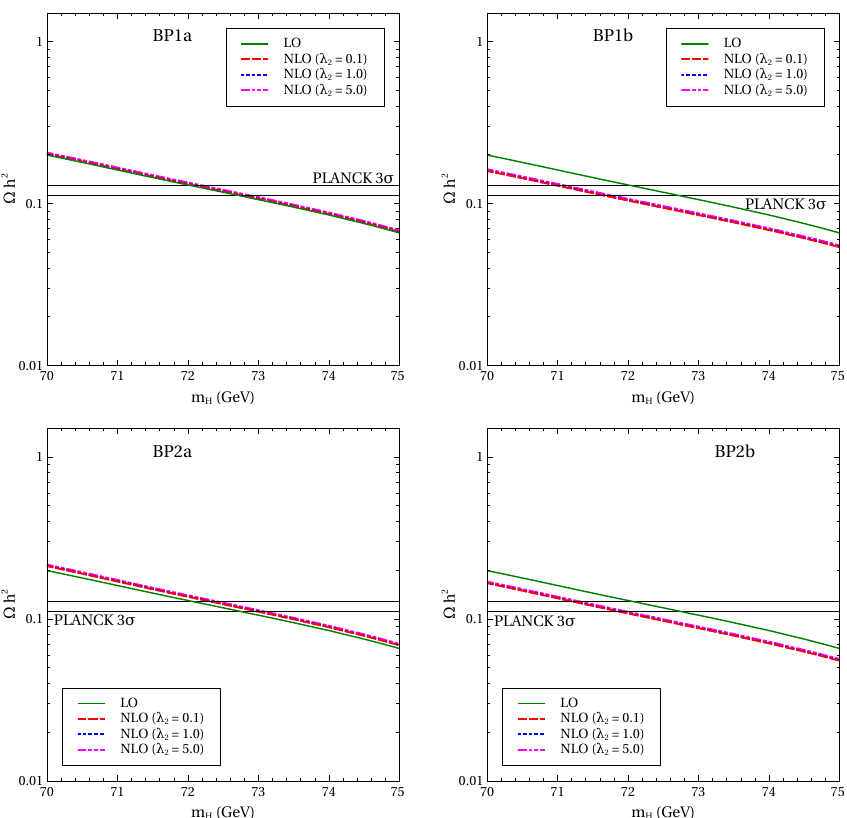
Figure 5 . Variation of the thermal relic with the DM mass (70 GeV < m H < 80 GeV). The tree level and one-loop values are denoted by the green solid and red dashed ( (cid:21) 2 = 0 : 1), blue dotted ( (cid:21) 2 = 1) and pink dot-dashed ( (cid:21) = 5)